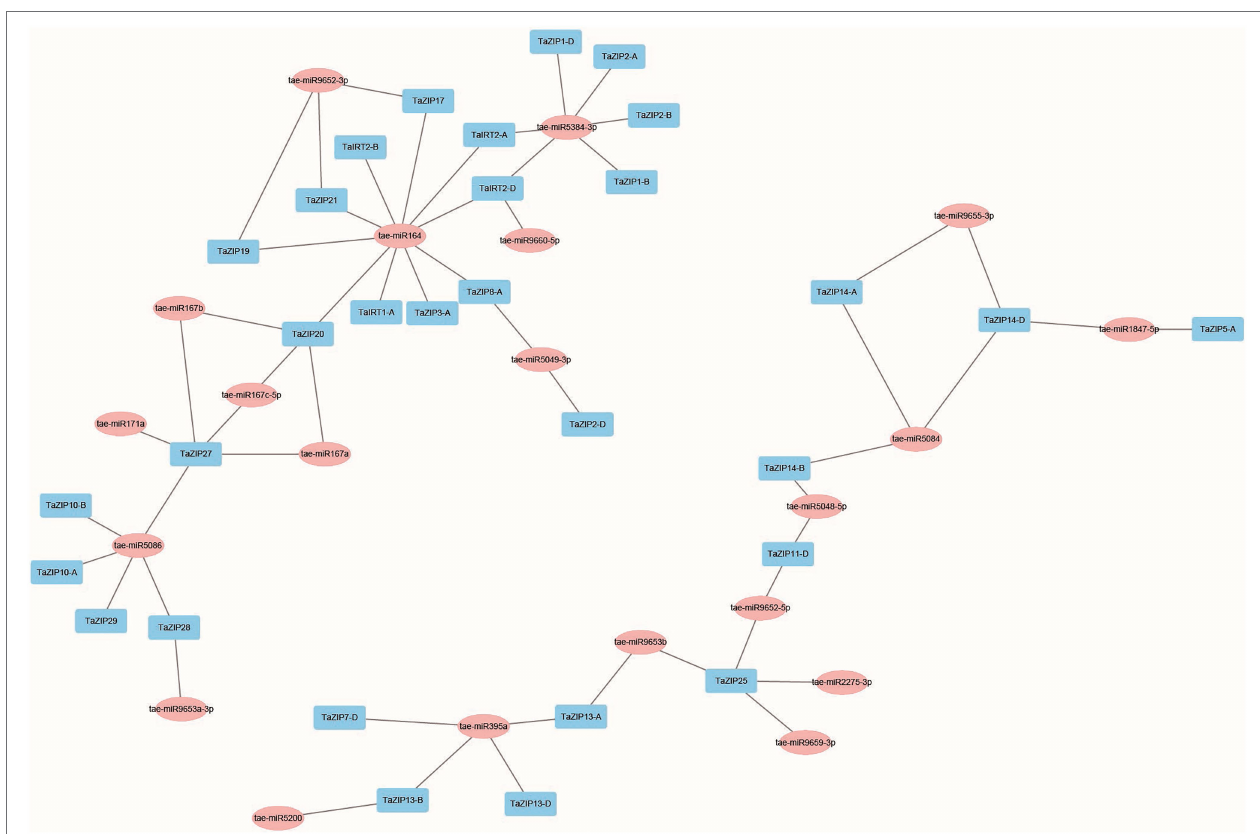
FIGURE 3 | Co-expression network of TaZIP cascade genes in wheat. Blue box: TaZIP gene in wheat; pink box: miRNAs found in